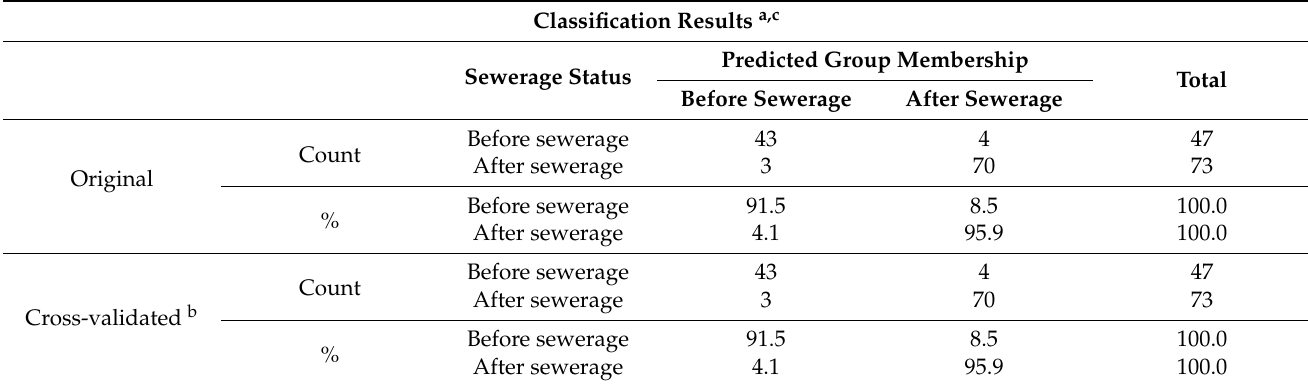
Table 5. Classification results of the discriminant analysis for groundwater